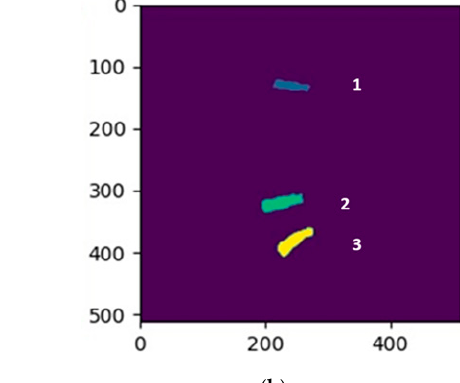
Figure 3. The sampling result of connected-component labeling for the three specific intervertebral discs: ( a ) the standard masks of the three intervertebral discs; ( b ) the connected-component labeling result of ( a ).